Question: What type of chart is this?
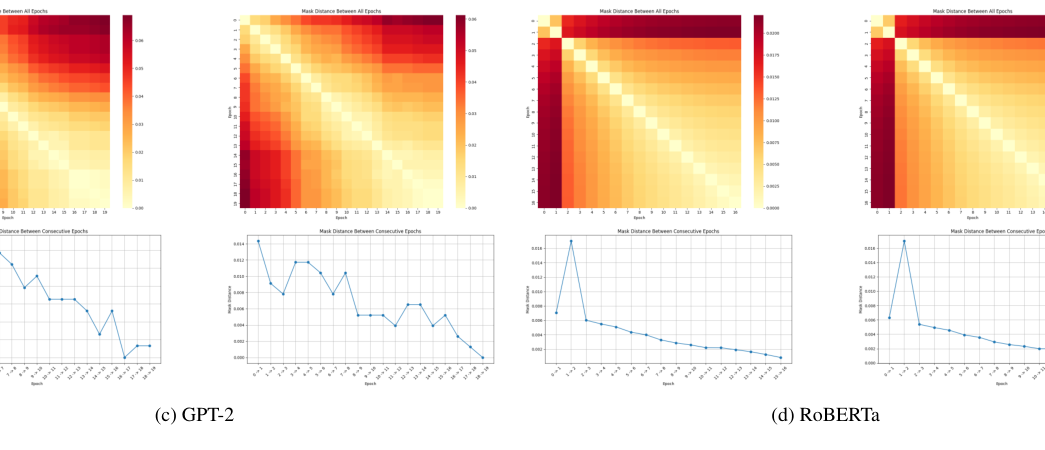
Answer: heatmap